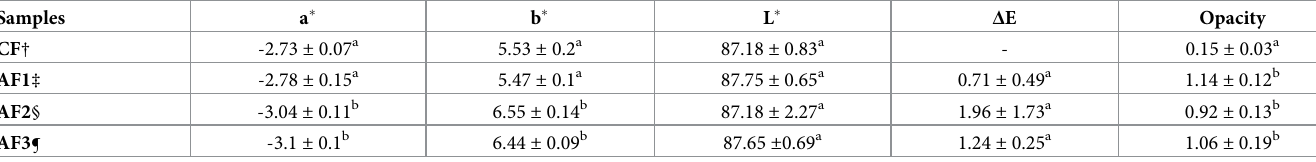
�� Each value represents the mean of 10 replicates with corresponding standard deviation. Data were statistically analysed with multiple range test, using the method of least significant difference (LSD) Fisher. Different lowercase letters denote statistically significant differences (p <